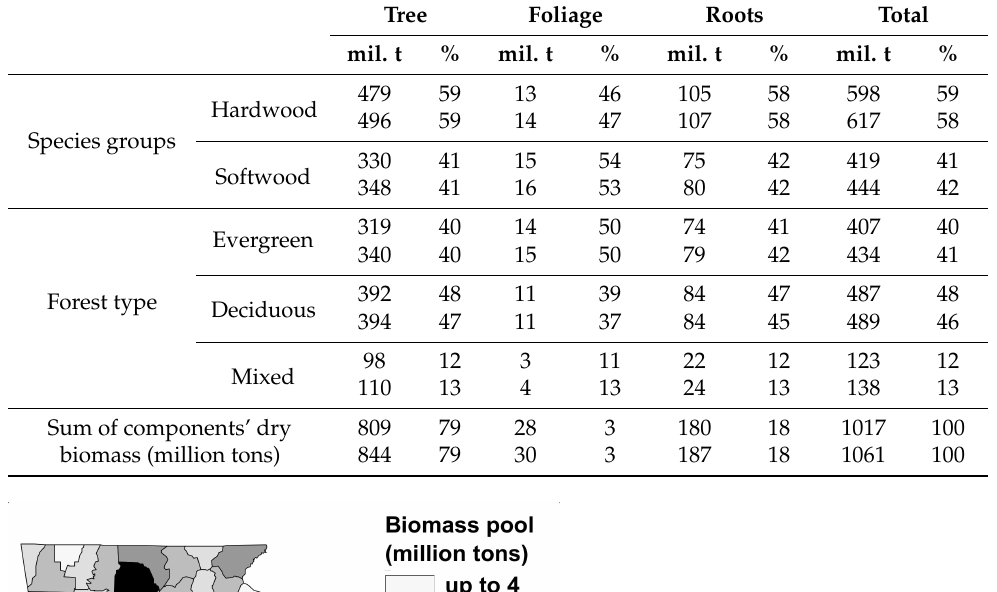
Table 2. Detailed analysis of dry biomass distribution (1989/1997).